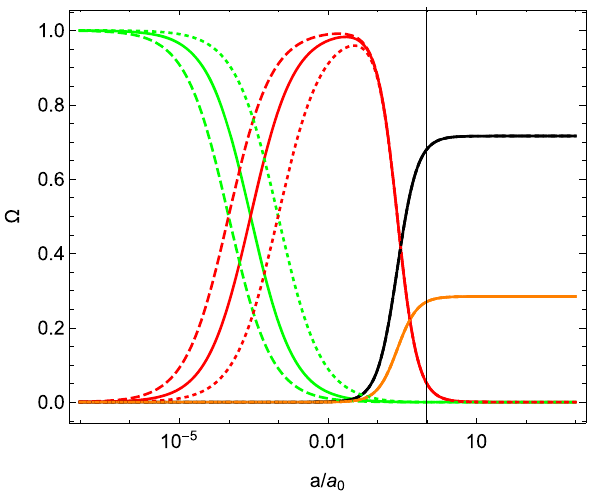
Fig. 1 The calculated cosmic evolutions of dimensionless density parameters as functions of a / a 0 . The present day a / a 0 = 1 is indicated by a vertical black solid line. The quantities (cid:13) de ,(cid:13) dm ,(cid:13) m , and (cid:13) r are represented by black, orange, red, and green curves. The calculations are carried out for different parameters in generalized Rastall gravity. The cosmic evolution evaluated by using the specific initial conditions which reproduces the measurements is presented by solid curves. Those obtained by using different perturbed initial conditions are indicated by dashed and dotted